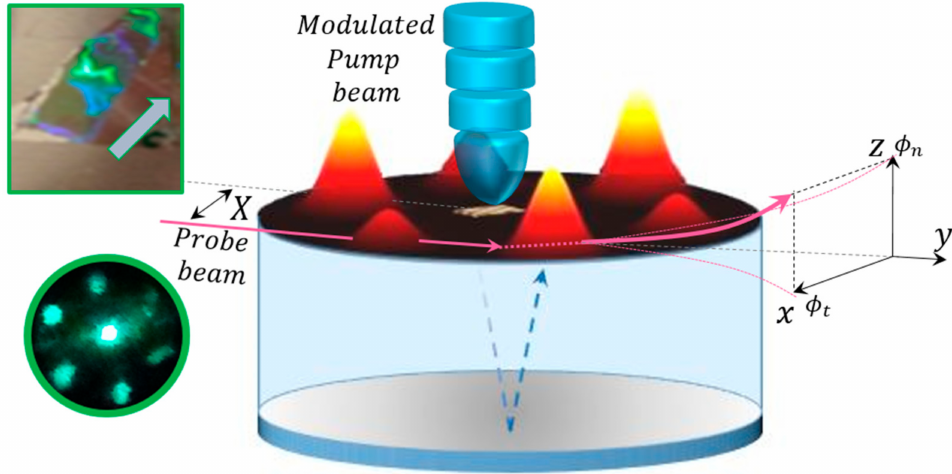
Figure 1. Simplified schematic of the photothermal deflection measurements of diffracted orders. Top left inset: photo of the sample. Bottom left inset: photo of the diffracted orders in Ag-plasmonic semi-nanoshell arrays (Ag-SNSA) metasurface when a pump beam at 514 nm excites